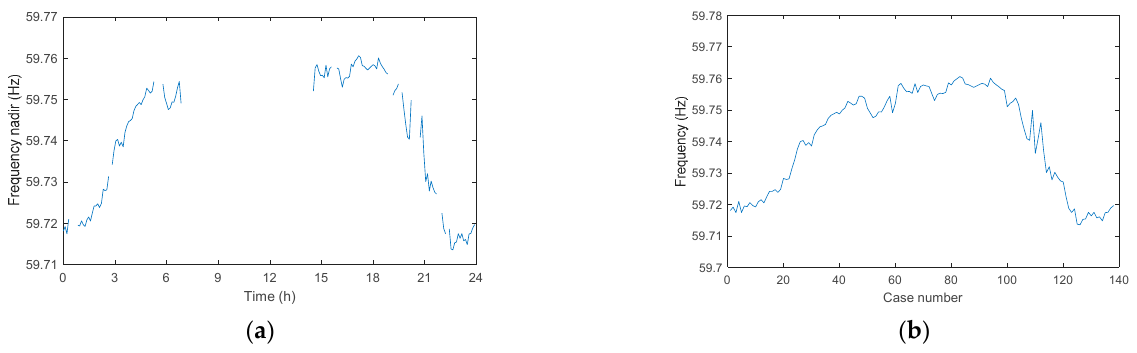
Figure 7. Simulated frequency nadir under the loss of two large generators; ( a ) with the horizontal axis being the time stamp for a 1-day time period, ( b ) with the horizontal axis being the index of cases being used.